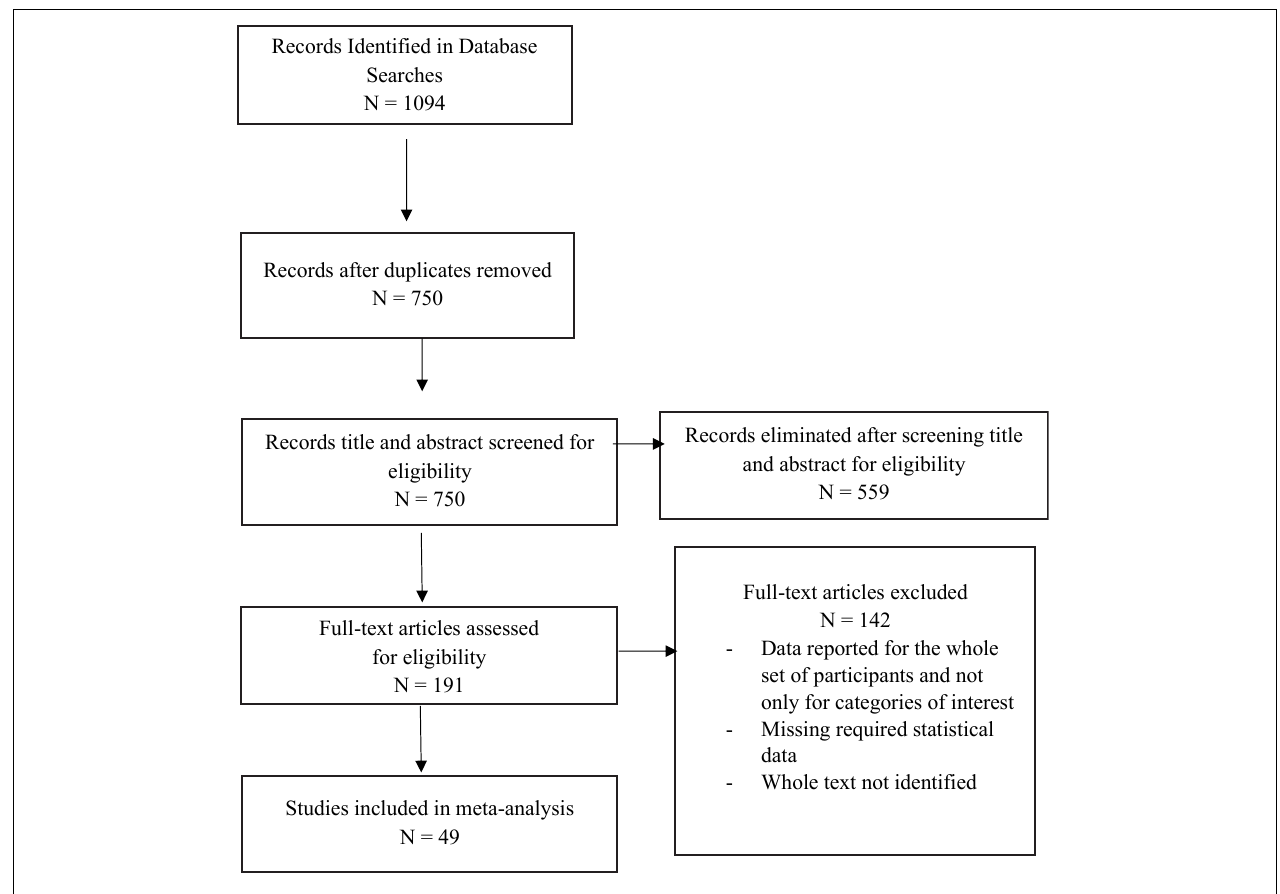
FIGURE 1 | PRISMA flow diagram.